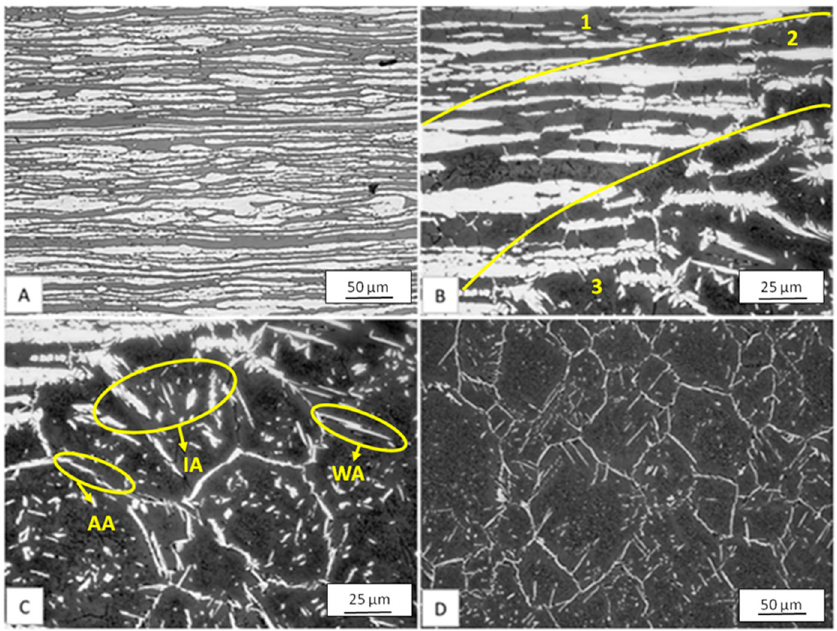
Figure 6. SAF 2507—Low heat input: ( A ): BM; ( B ): 1—BM; 2—LT-HAZ; 3—HT-HAZ; ( C ): HT-HAZ; ( D ): WM; Beraha II Etching. Where: ferrite—dark/dark brown, austenite—light brown, WA—Widmanstätten Austenite, IA—Intragranular Austenite, AA—Allotriomorphic Austenite.